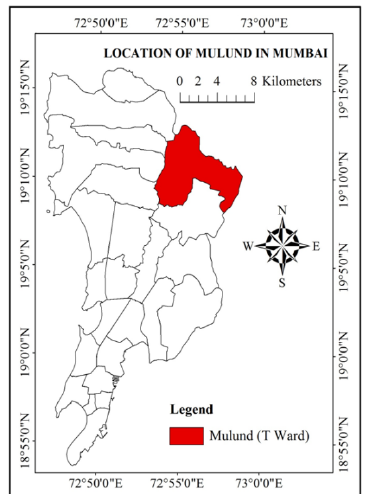
Figure 1. Map showing the location of Mulund (T - Ward) in Mumbai (Source: Prepared by the author using ArcGIS 10.4.1